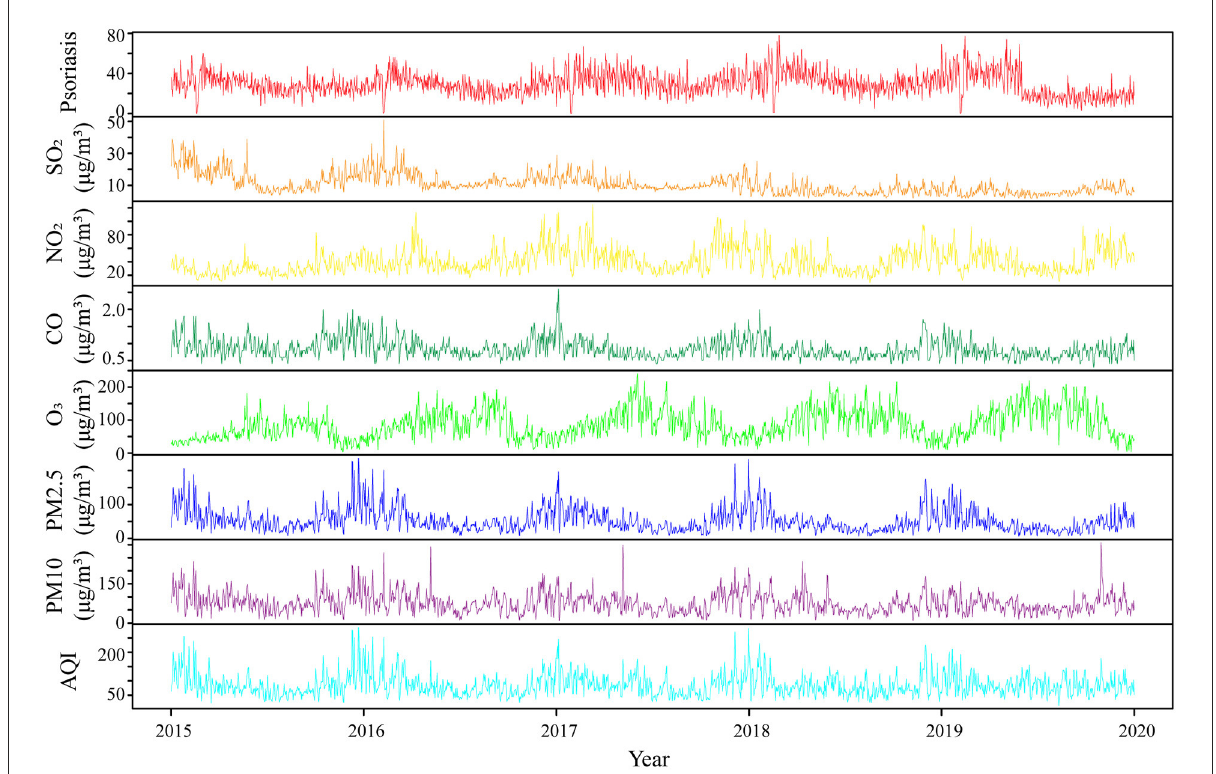
FIGURE1 Time series characteristics of air pollutants and outpatients with psoriasis in Hefei city from 2015 to 2019. SO 2 , sulfur dioxide; NO 2 , nitrogen dioxide; CO, carbon monoxide; O 3 , ozone; PM 2.5 , fine particulate matter; PM 10 , inhalable particulates; AQI, air quality